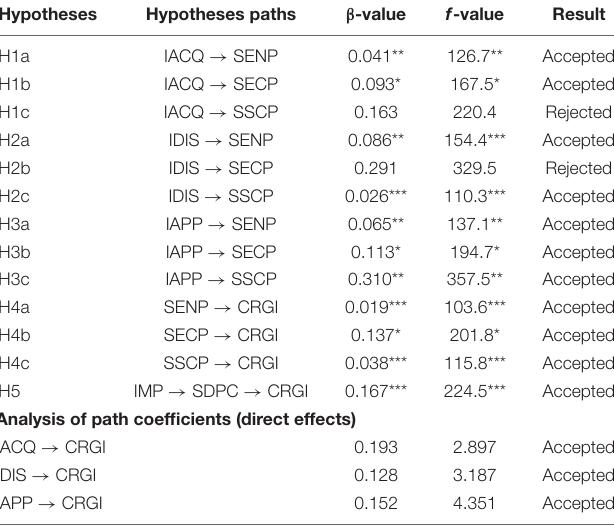
TABLE 4 | Hypotheses’